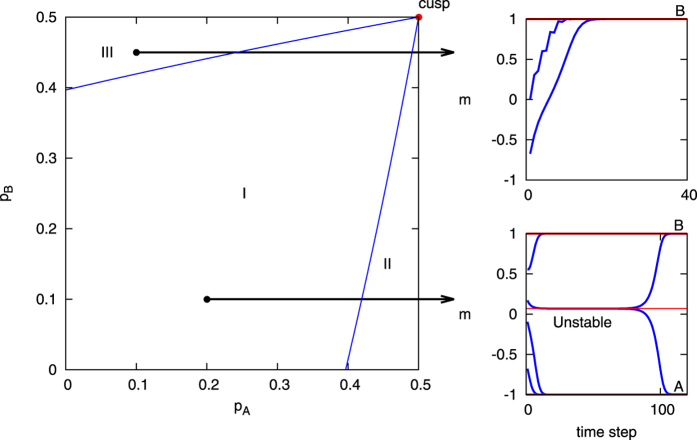
Mean-field diagram of the increasing commitment naming game with two competing committed groups.The plots are calculated by the mean-field equations with commitment strength w = 10. (1) The left plot is a phase diagram containing three regions. (2) The right plots show trajectories of points in region I and III. The top right is the case where (pA = 0.1, pB = 0.45) and the bottom right is the case where (pA = 0.2, pB = 0.1).